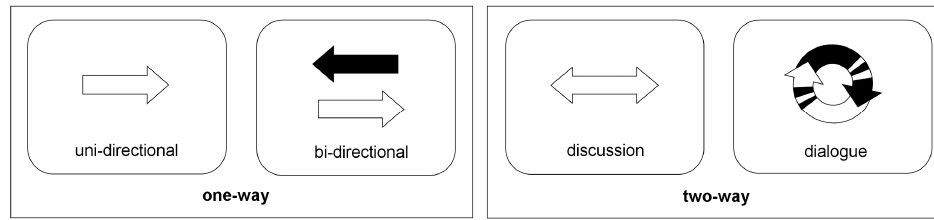
Figure 1. Quality of flows of information in participatory